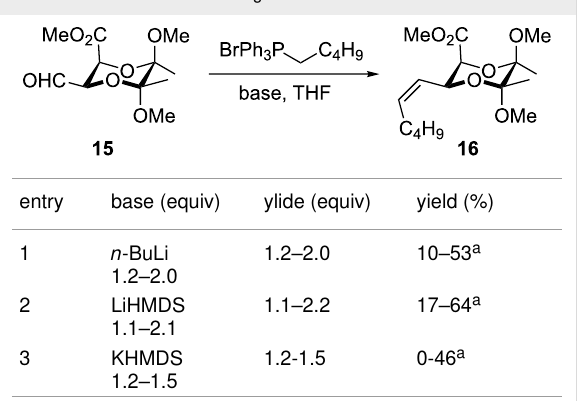
Table 1: Conditions of the Wittig